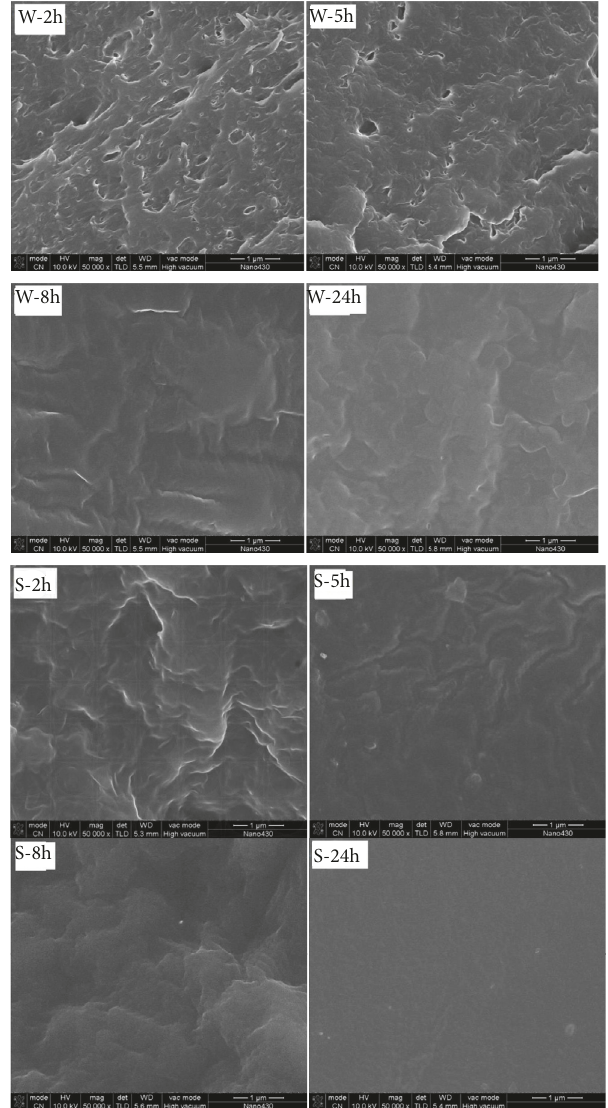
Figure 6: The microstructures of the films prepared with different film formation times.